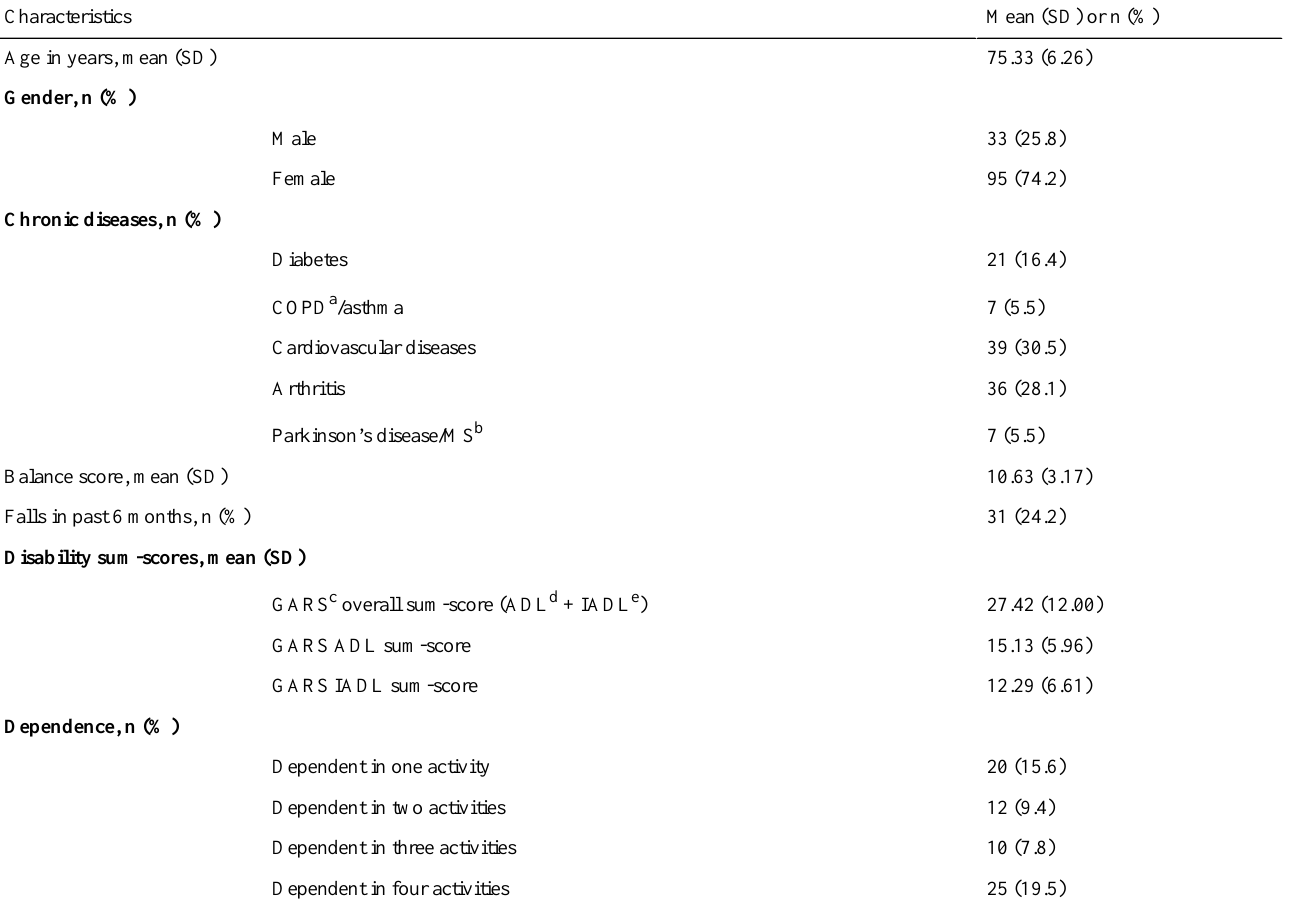
Table 1. Baseline characteristics of participants